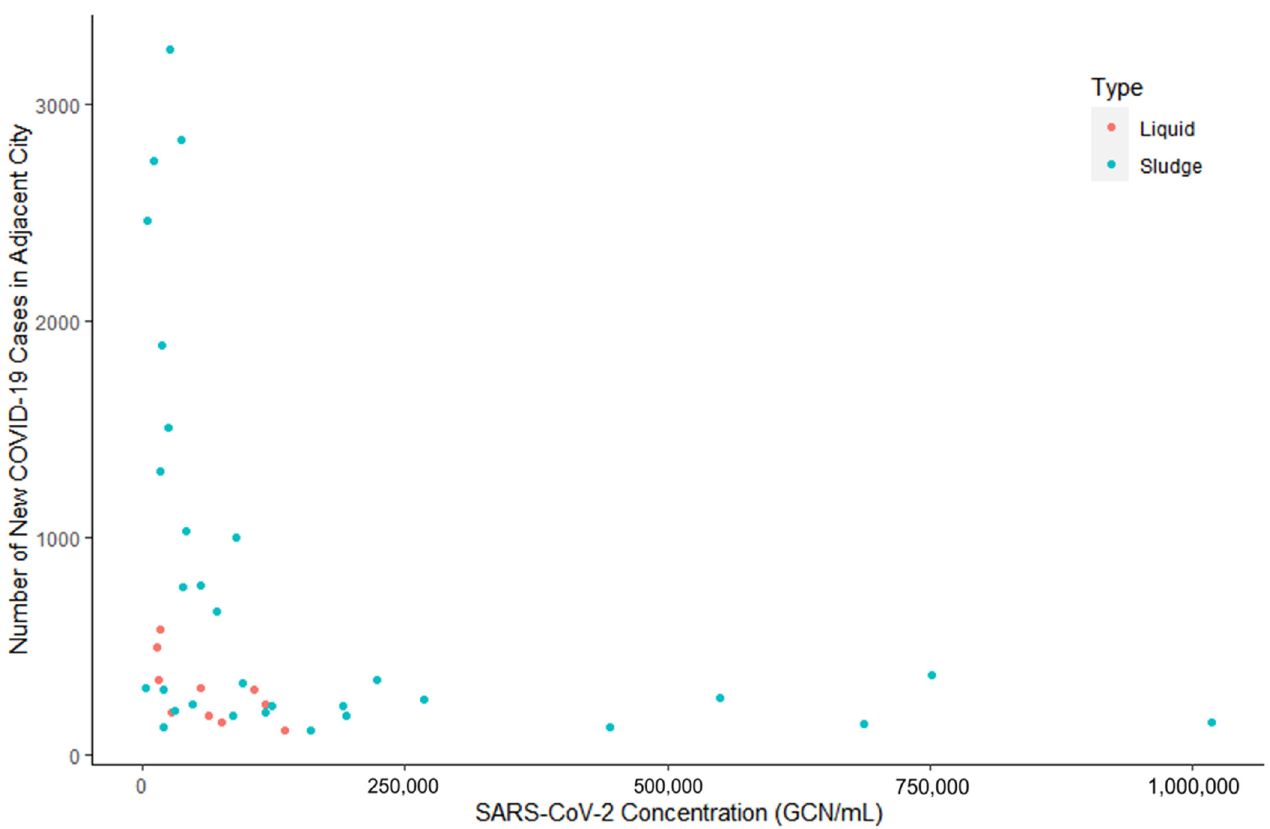
Figure 2. SARS-CoV-2 concentration (GCN/mL) from the positive wastewater in the liquid fraction (green) and sludge fraction (pink) and the number of new COVID-19 cases in adjacent city on the collection date.